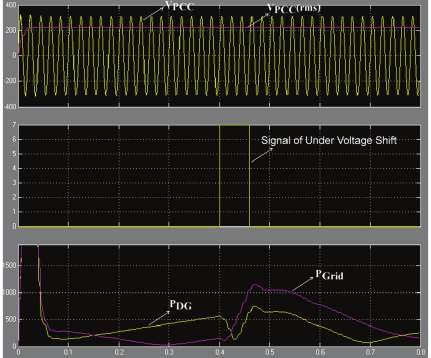
on normal voltage range. PCC